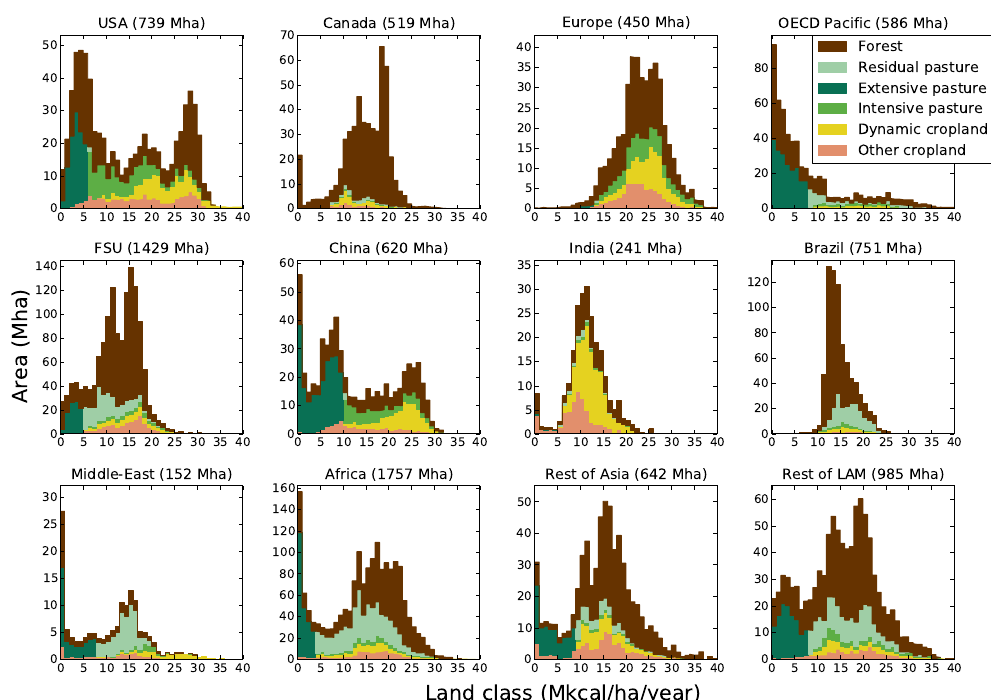
Fig. 12. Histogram of the land area classes of potential yield in the 12 Nexus Land-Use regions at the base year 2001. X-axis in GJha − 1 yr − 1 ranges from 0 to 167.